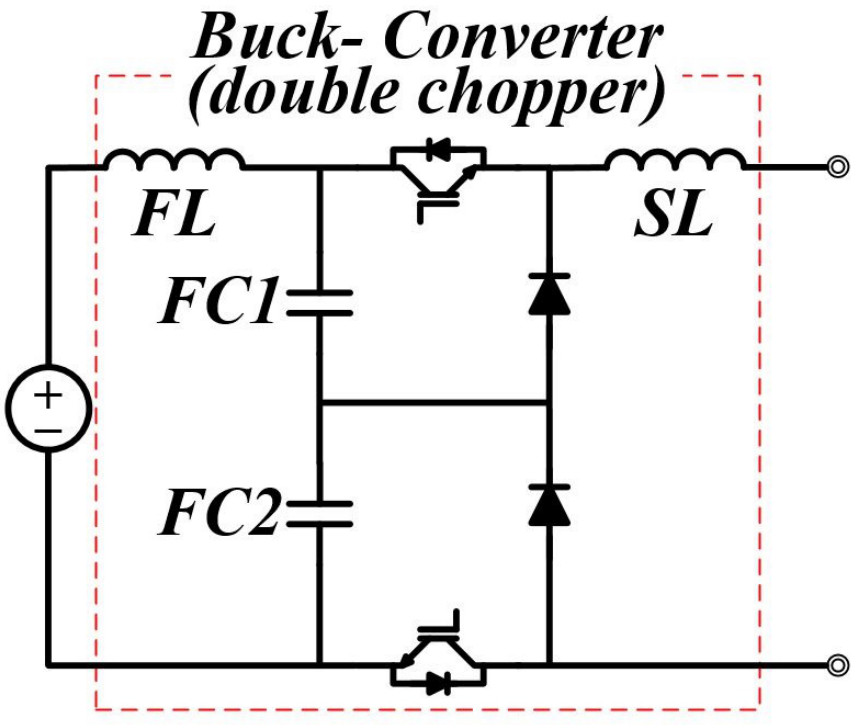
Figure 7. Part of buck